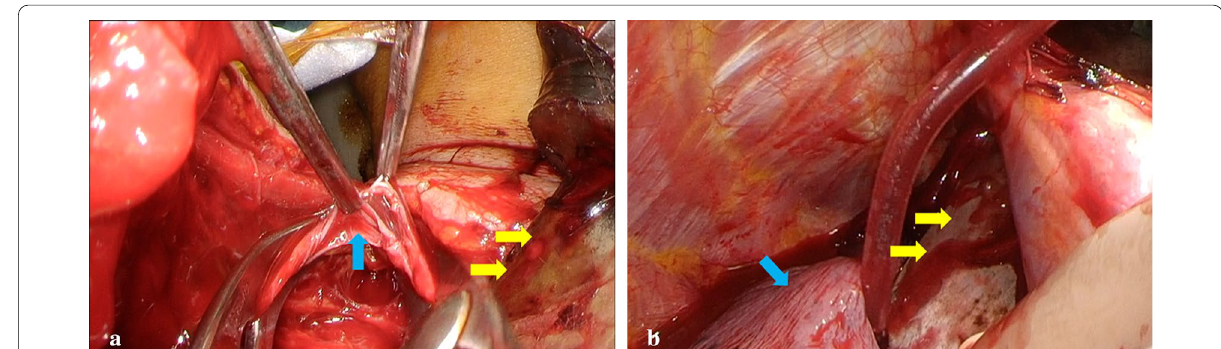
Fig. 2 Intraoperative image. a The right internal jugular vein is damaged (blue arrow) by the knife (yellow arrow). b The knife (yellow arrow) penetrated between the right brachiocephalic artery and vein and reached the right pleural cavity. The blade tip had penetrated the dorsal right upper lobe (blue